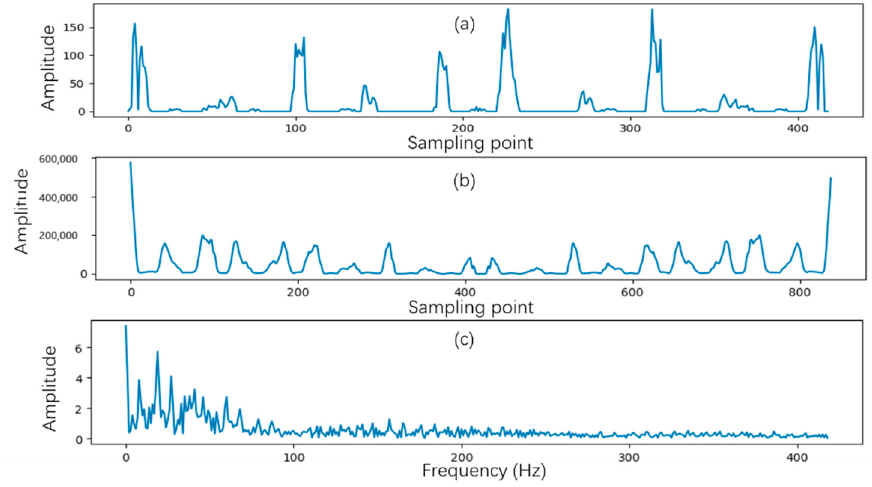
Figure 11. Extracting the image period from the ROI. ( a ) Statistical waveform; ( b ) self-correlation operation result; ( c ) spectrogram.